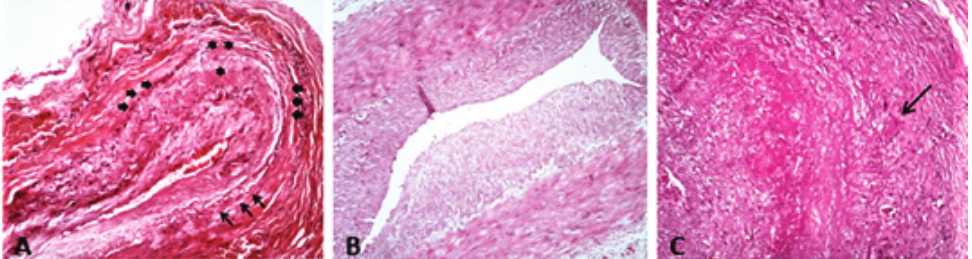
Figure 1. (A) Healed arteritis: note the narrow lumen and minimal intramural lymphocytic infiltration, scarring, and fibrosis (asterisks) in areas with destroyed elastic lamina (short arrows) compared to the areas of intact elastic lamina (long arrows), (H&E staining × 40). (B) Normal artery, negative for GCA (H&E staining × 40). (C) Active GCA: note the obstruction of the lumen, arterial wall thickening, elastic lamina fragmentation, and intramural inflammation with multinucleated giant cells (arrow), (H&E staining × 100). GCA, giant cell arteritis; H&E, Hematoxylin and Eosin